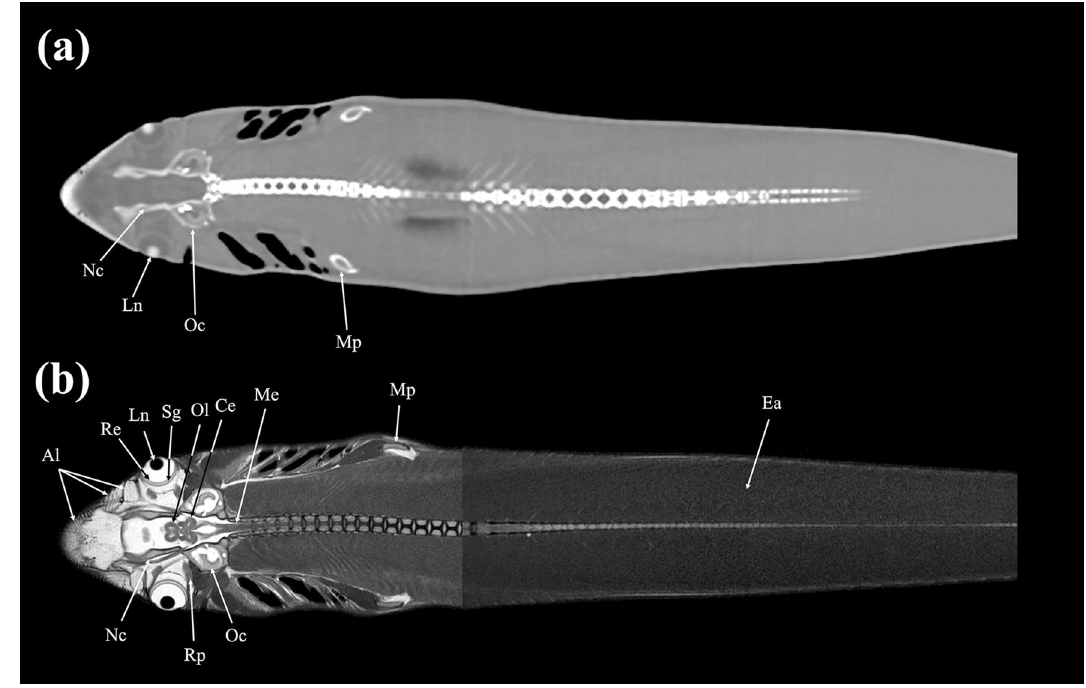
Figure 18. Dorsal ( a ) CT and ( b ) MR images of a banded houndshark ( Triakis scyllium ) at level 18 of Fig. 25. Al Ampullae of Lorenzini, Ce Cerebellum, Ea Epaxial, Sg Scleral cartilage, Ln Lens, Me Medulla oblongata, Mp Metapterygium, Nc Neurocranium, Oc Otic capsule, Ol Optic lobe, Re Retina, Rp Rectus posterior.